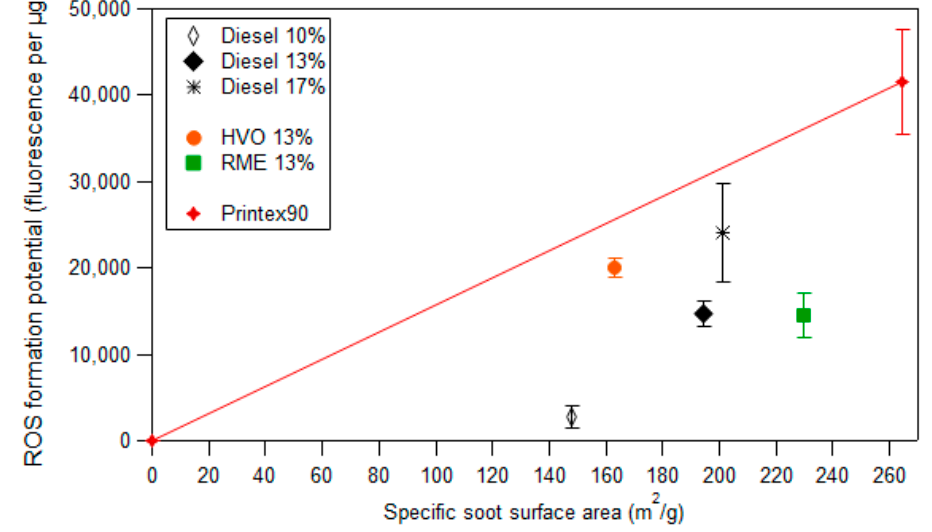
Figure 6. The reactive oxygen species (ROS) formation potential per mass unit (with error bars of ±1 standard error of the mean) versus the soot specific surface area (m 2 /g). The red line shows the hypothetical ROS formation efficiency for materials with the same ROS formation efficiency per specific surface area (SSA) as Printex90. The ROS formation potential of the particle samples were compared to the Printex90 SSA adjusted potential. Diesel 10% (intake O 2 ) showed only 10% of this potential, while diesel and RME at 13% intake O 2 had 43% and 46% respectively. The HVO (13% intake O 2 ) and diesel at 17% intake O 2 had the highest ROS formation potential with 69% and 64% respectively.